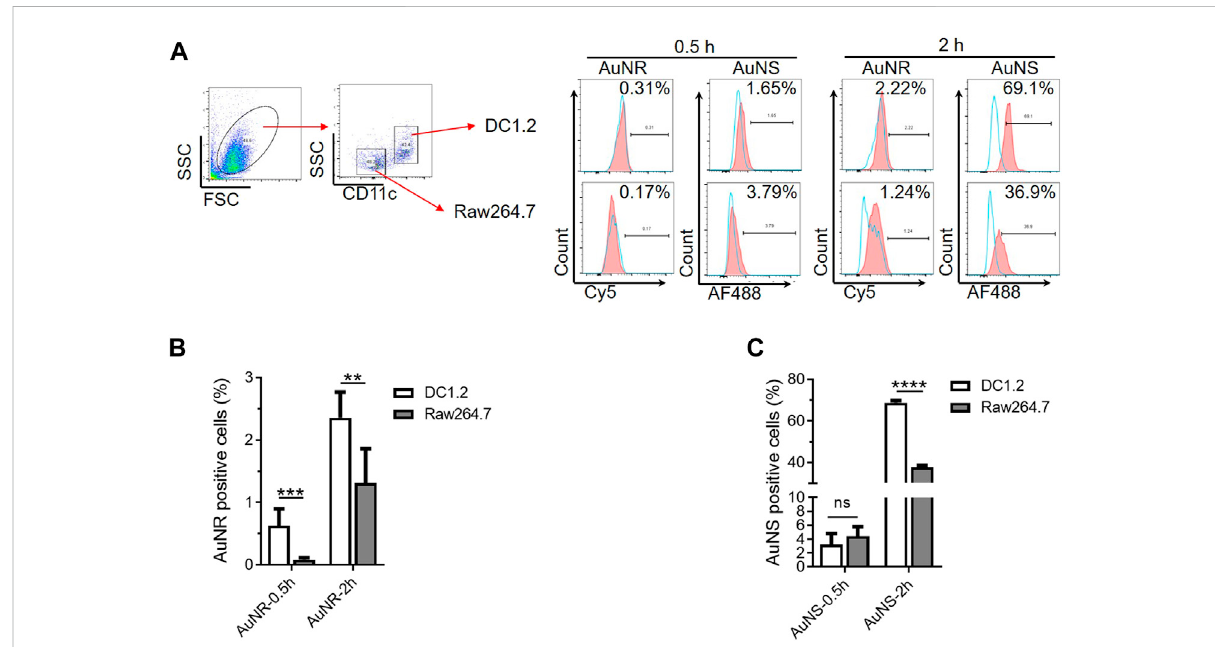
FIGURE 4 The co-culture system of macrophages and DCs in vitro are not suitable for studying the interactions between nanoparticles and TIMs and TIDCs. (A) Flow cytometry analyses of AuNR and AuNS accumulation 0.5 h and 2 h under DC1.2 and Raw 264.7 cell co-culture condition. (B,C) Statistical analysis of AuNR positive cells (B) or AuNS positive cells (C) under DC1.2 and Raw 264.7 cell co-culture system ( n = 3). ** p < 0.005, *** p < 0.0005, **** p <